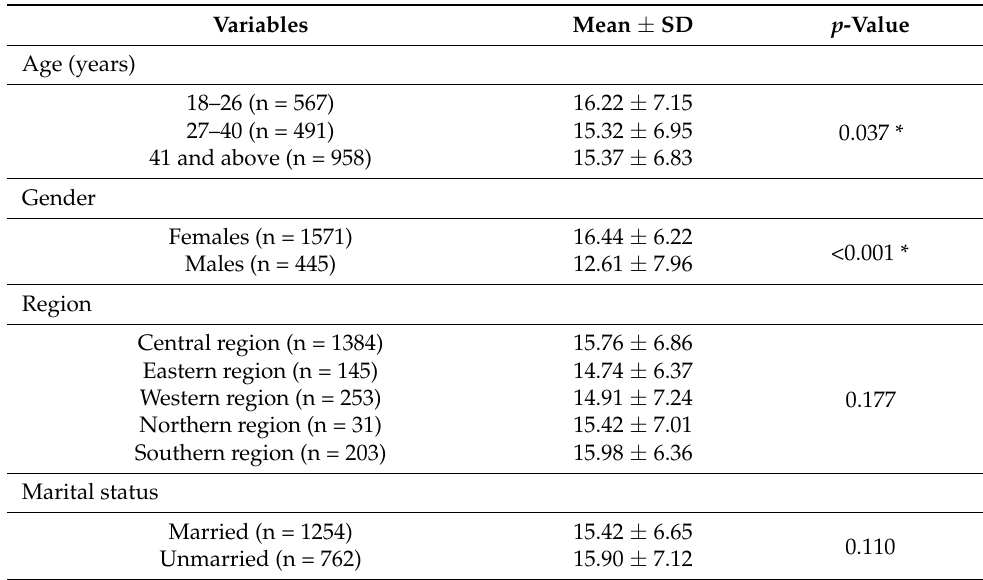
Table 3. Average knowledge scores, mean, and standard deviation (SD) .